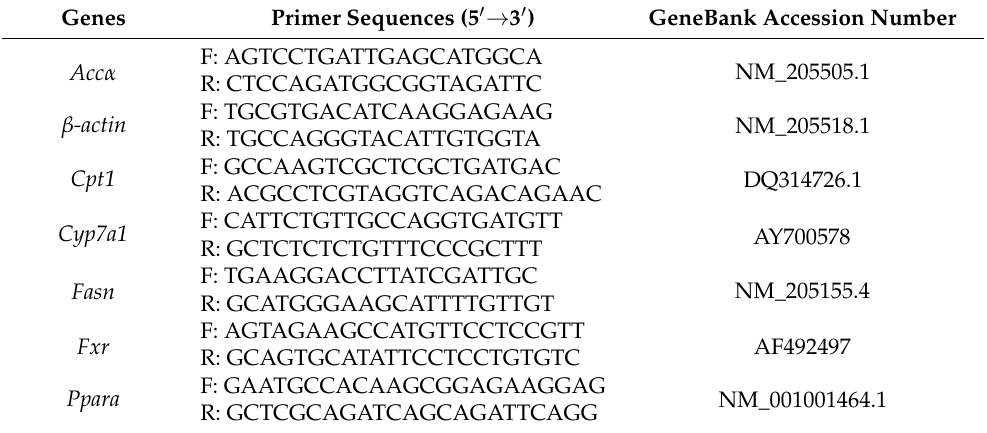
Table 2. Primer sequences for each target